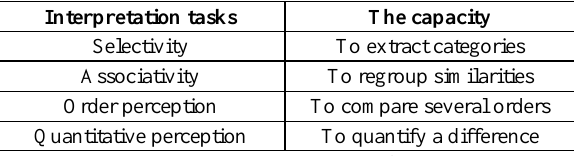
Table 2 Interpretation tasks